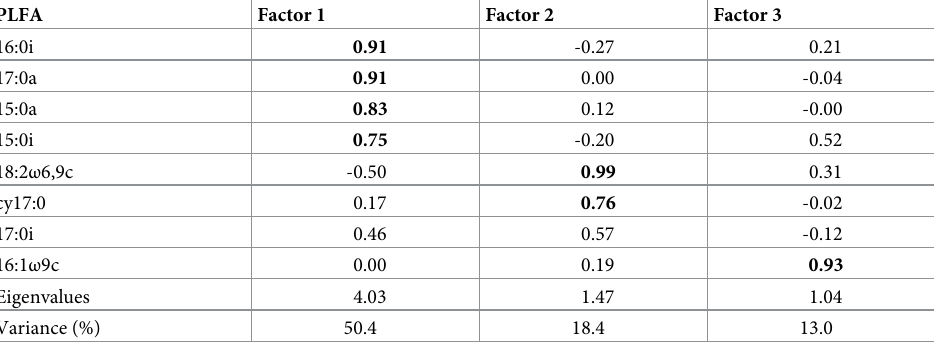
Table 7. Oblique solution primary pattern matrix of the principal component analysis (orthotran/varimax trans- formation; n = 60) for those phospholipid fatty acids (PLFA) that indicate Gram-positive (15:0a, 15:0i,